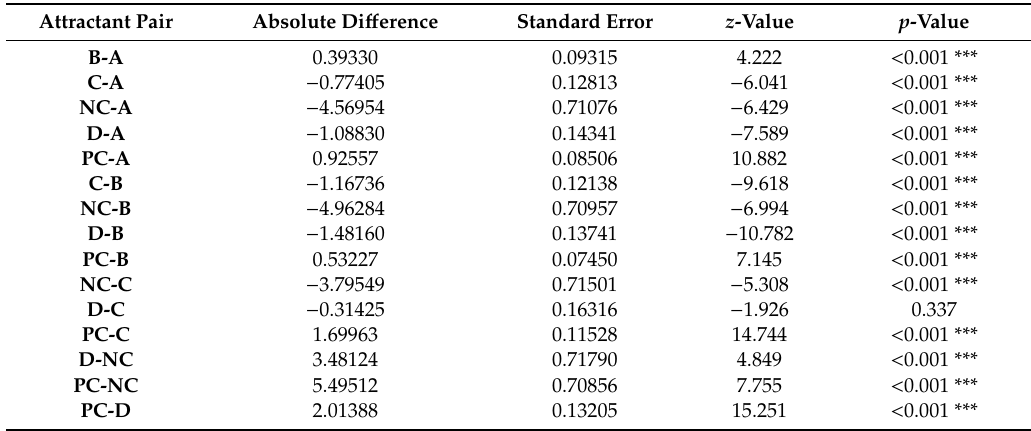
Table 6. Pairwise comparison of attractant e ffi cacy in trapping female H. abietis (based on number of individuals trapped across all